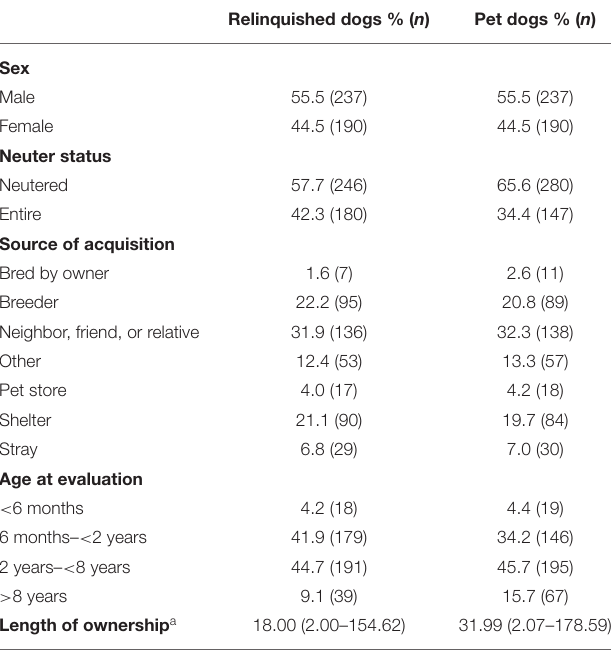
TABLE 1 | Characteristics of